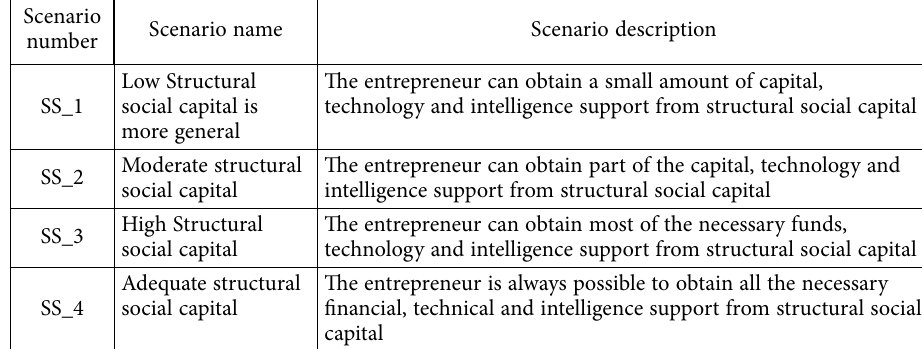
Table 2. Description of Structural Social Capital